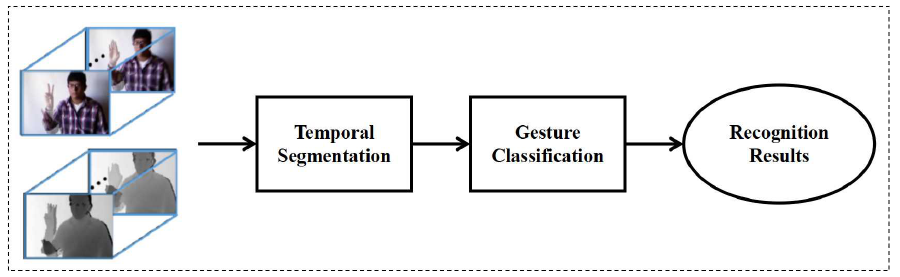
Figure 3. The overview of our proposed method for continuous gesture recognition. The proposed method consists of two phases: temporal segmentation and gesture recognition.